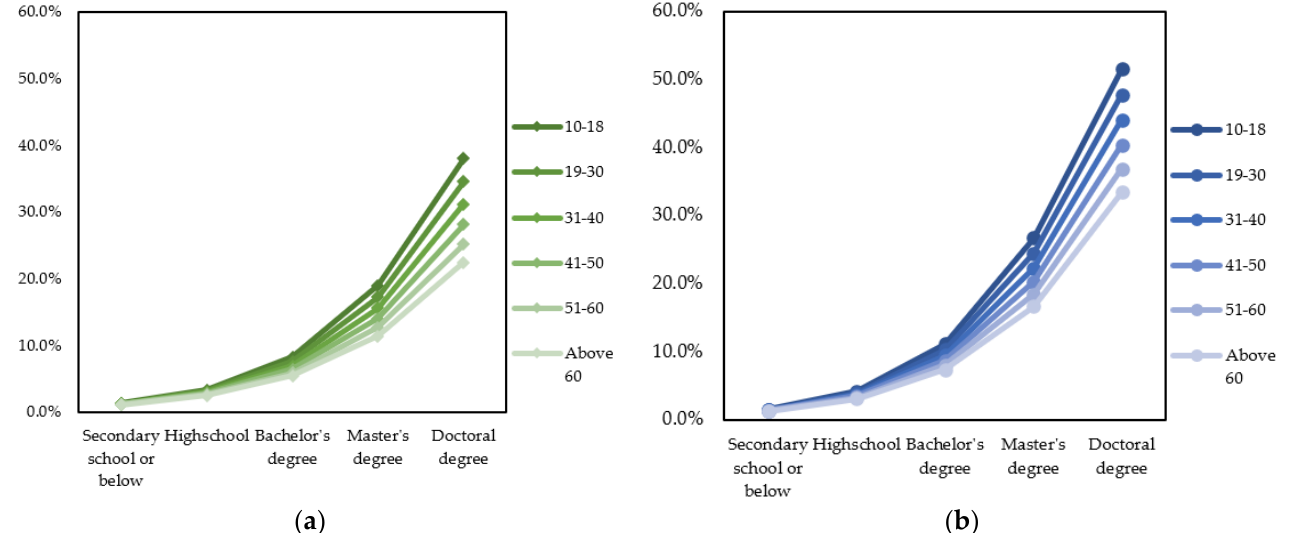
Figure 11. Probabilities to have international migration intention based on educational level and age group. ( a ) Male urban inhabitants; ( b ) female urban inhabitants .